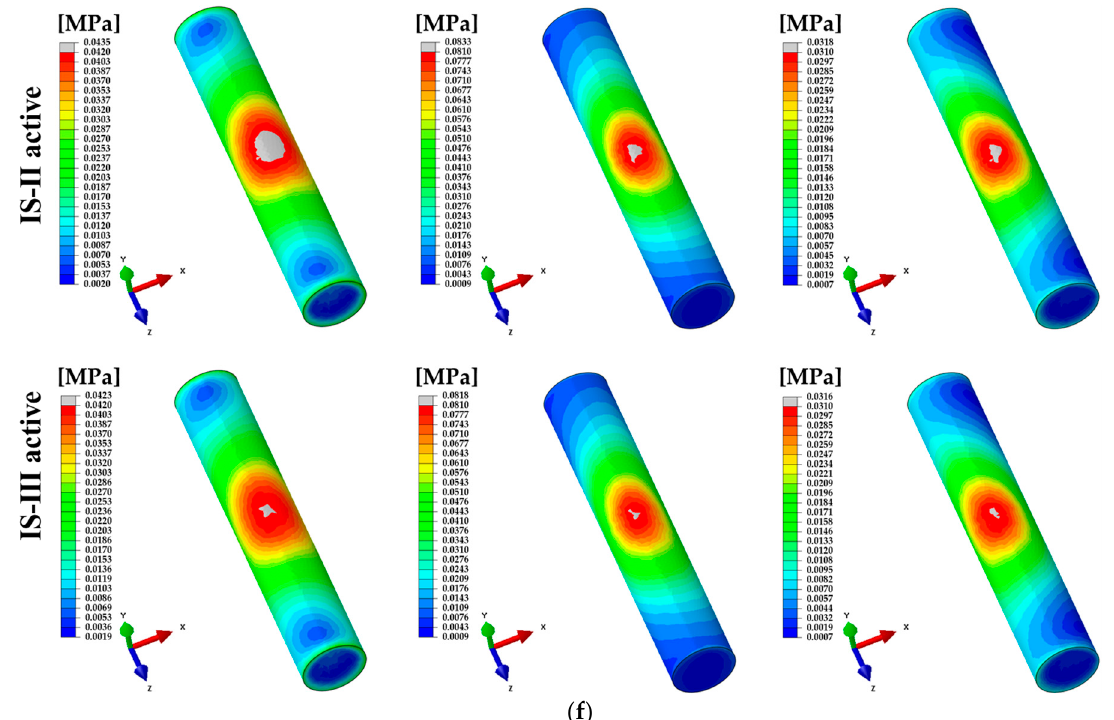
Figure 9. The distribution of von Mises stress under various loads. ( a ) Cortical- and ( b ) cancellous-bones, ( c ) fixture, ( d ) abutment, ( e ) abutment screw, and ( f ) nerve for IS-II and IS-III models.